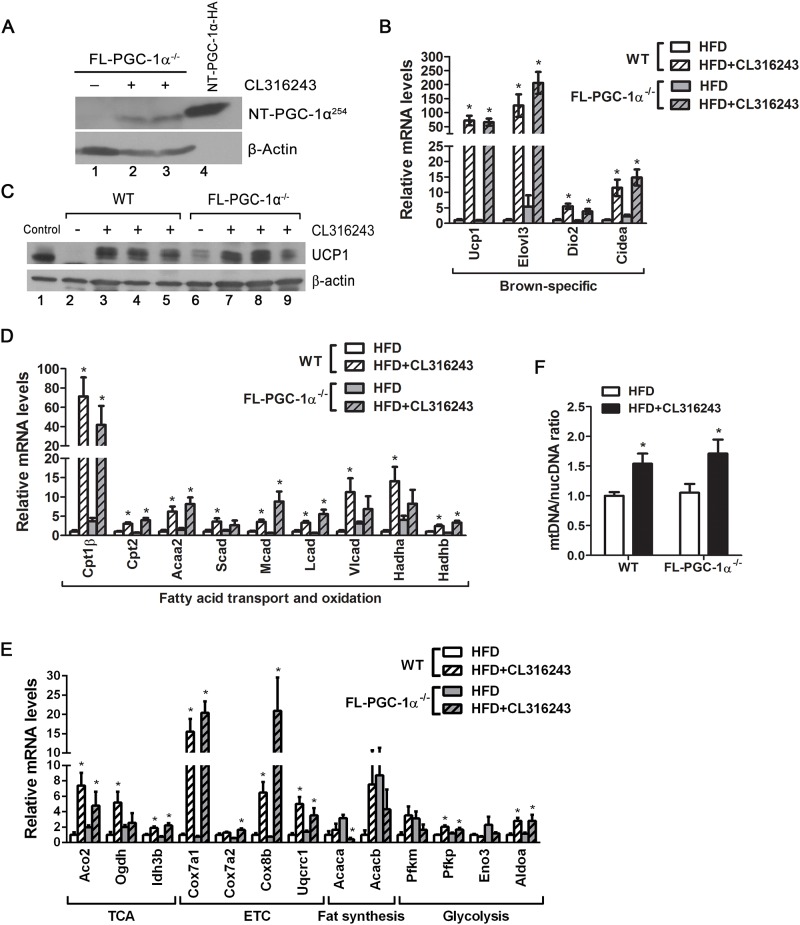
Gene expression changes in FL-PGC-1α-/- inguinal white adipose tissue in response to CL316243.(A) Increased expression of NT-PGC-1α254 by β3-AR activation in FL-PGC-1α-/- IWAT. NT-PGC-1α-HA in HEK293 cells was used as a positive control. FL-PGC-1α-/- mice were fed a HFD for 2 weeks, followed by the treatment with or without CL316243 for 6 days on HFD. (B, D, E) Quantitative real-time PCR analysis of a number of metabolic genes in WT and FL-PGC-1α-/- IWAT (n = 8 per group). HFD vs HFD+CL316243: *P < 0.05. (C) Western blot analysis of UCP1 expression in IWAT whole cell extracts (100 μg). BAT extracts (10 μg) were added to WT IWAT extract (- CL316243) as a positive control for UCP1. (F) The ratio of mitochondrial DNA (mtDNA) relative to nuclear genome (nucDNA) was analyzed in IWAT (n = 8 per group). *P < 0.05.